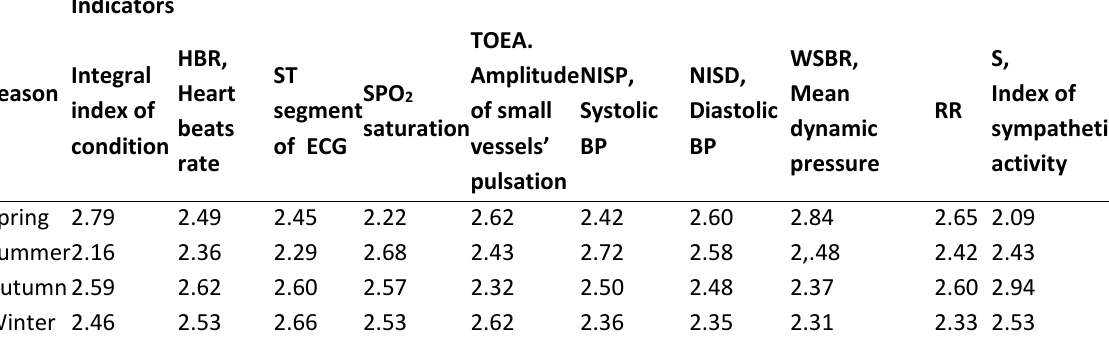
Table 1. Season fluctuations of cardio-haemo dynamic by Freedman’s criterion in the group of tested students